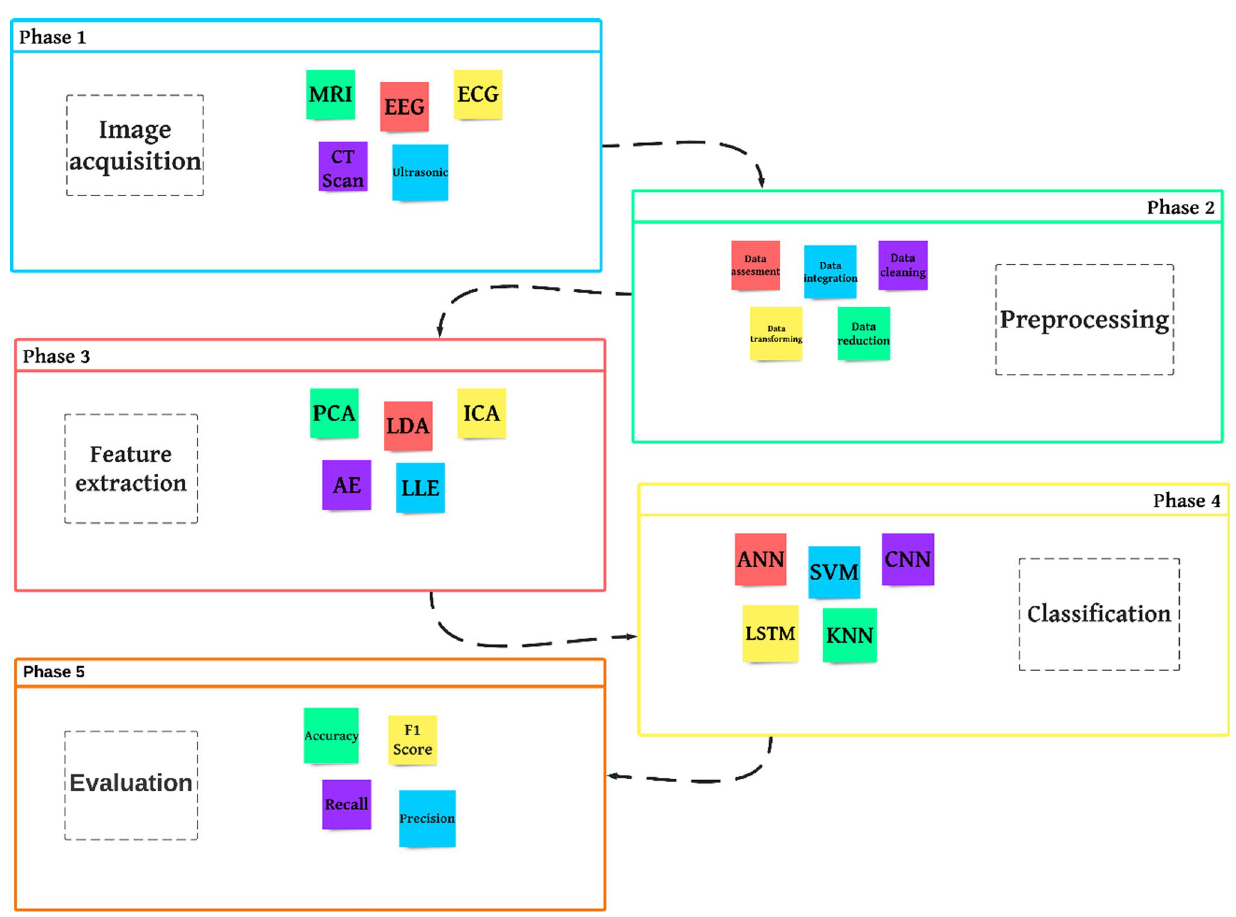
Fig. 2 The classification process phases in medical image analysis